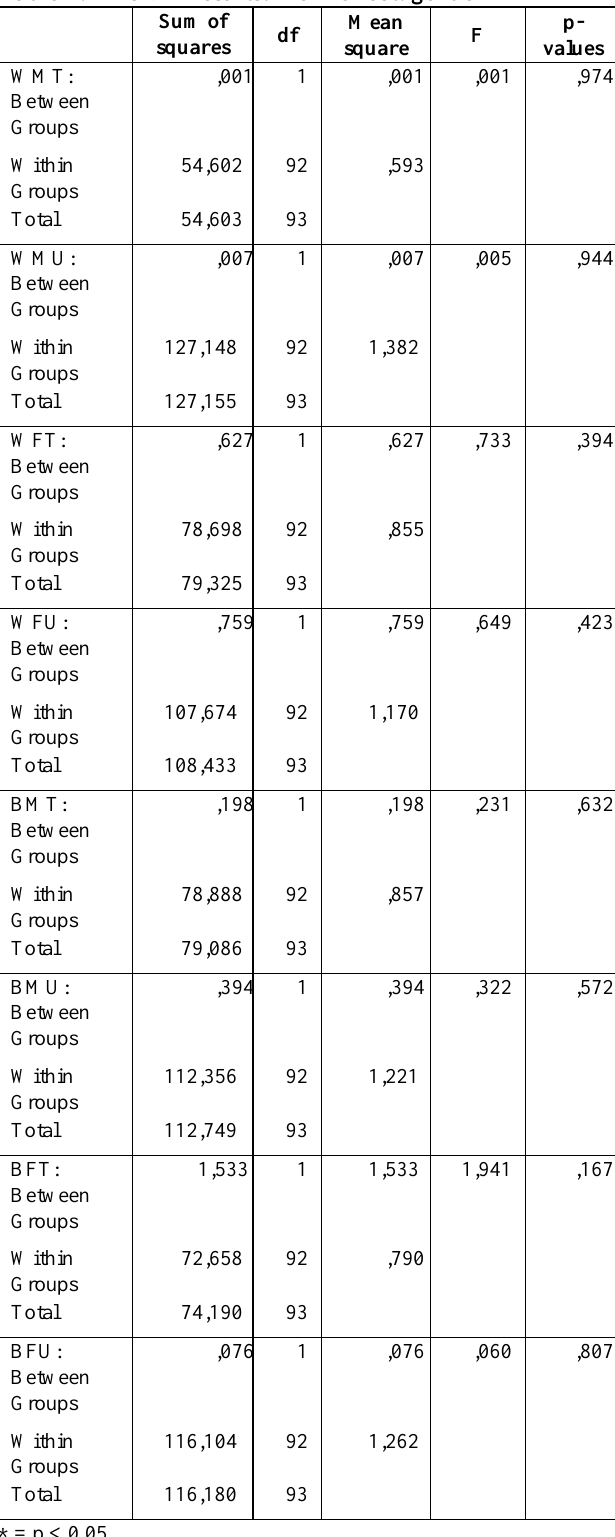
Table 2: ANOVA results: Main effect: gender Sum